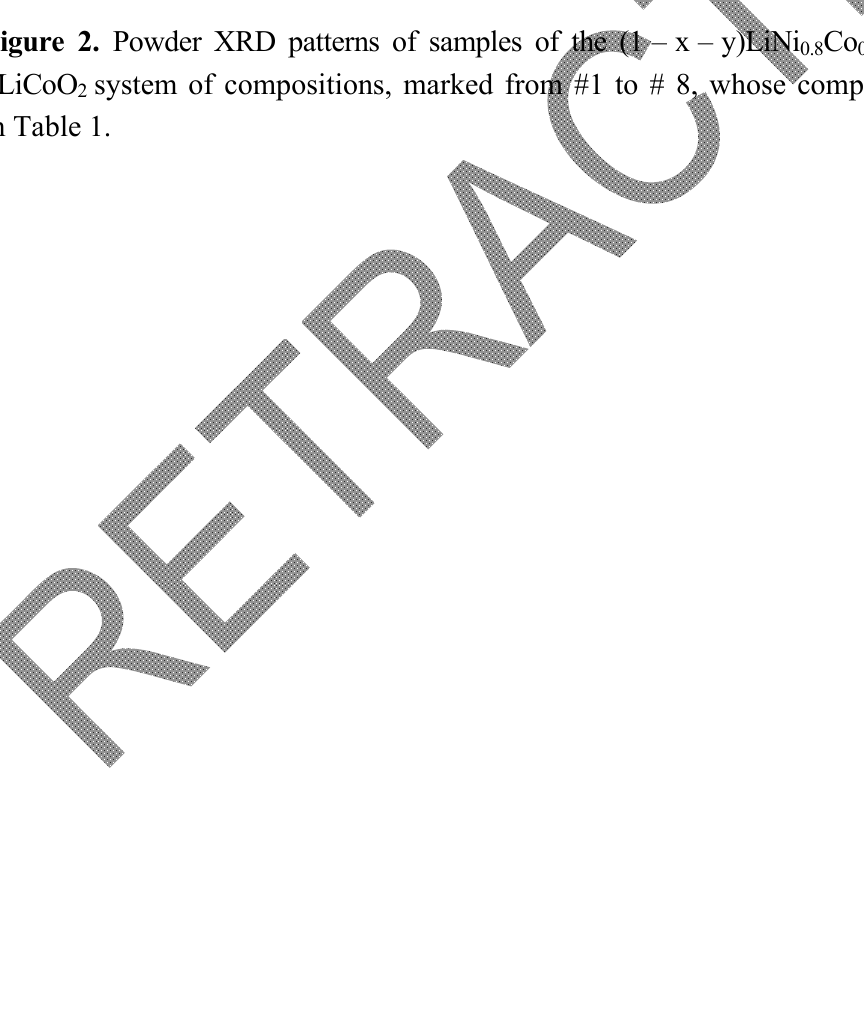
Figure 2. Powder XRD patterns of samples of the (1 – x – y)LiNi